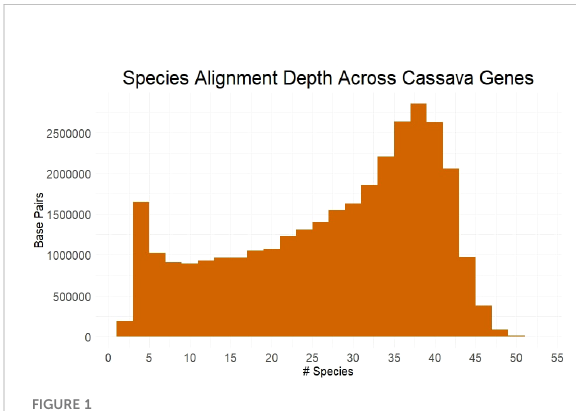
FIGURE 1 Species Alignment Depth Across Cassava Genes. Alignment depth represented by the number of species with homologous alleles in each multiple sequence alignment at any given protein coding base pair in the cassava